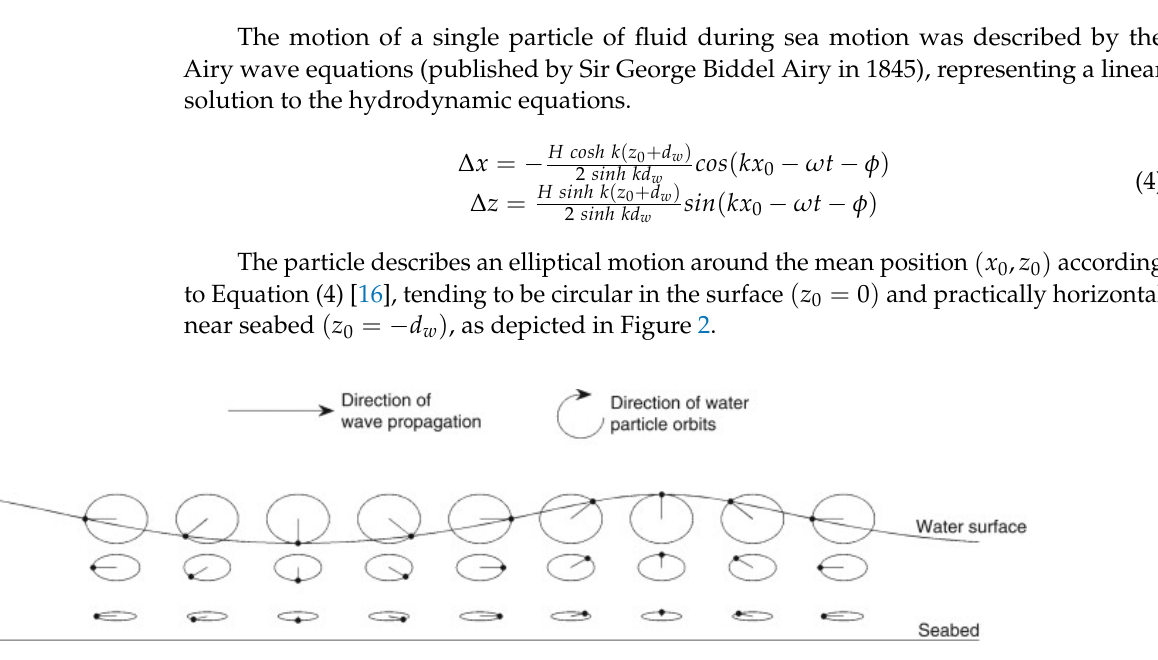
Figure 2. Particle motion in sea wave (Reproduced with permission 5139240948876 from [17], Elsevier, 2012). Indeed, if the quote z 0 tends to − d w (seabed), the factor cosh k ( z 0 + d w ) is equal to 1 while sinh k ( z 0 + d w ) is equal to